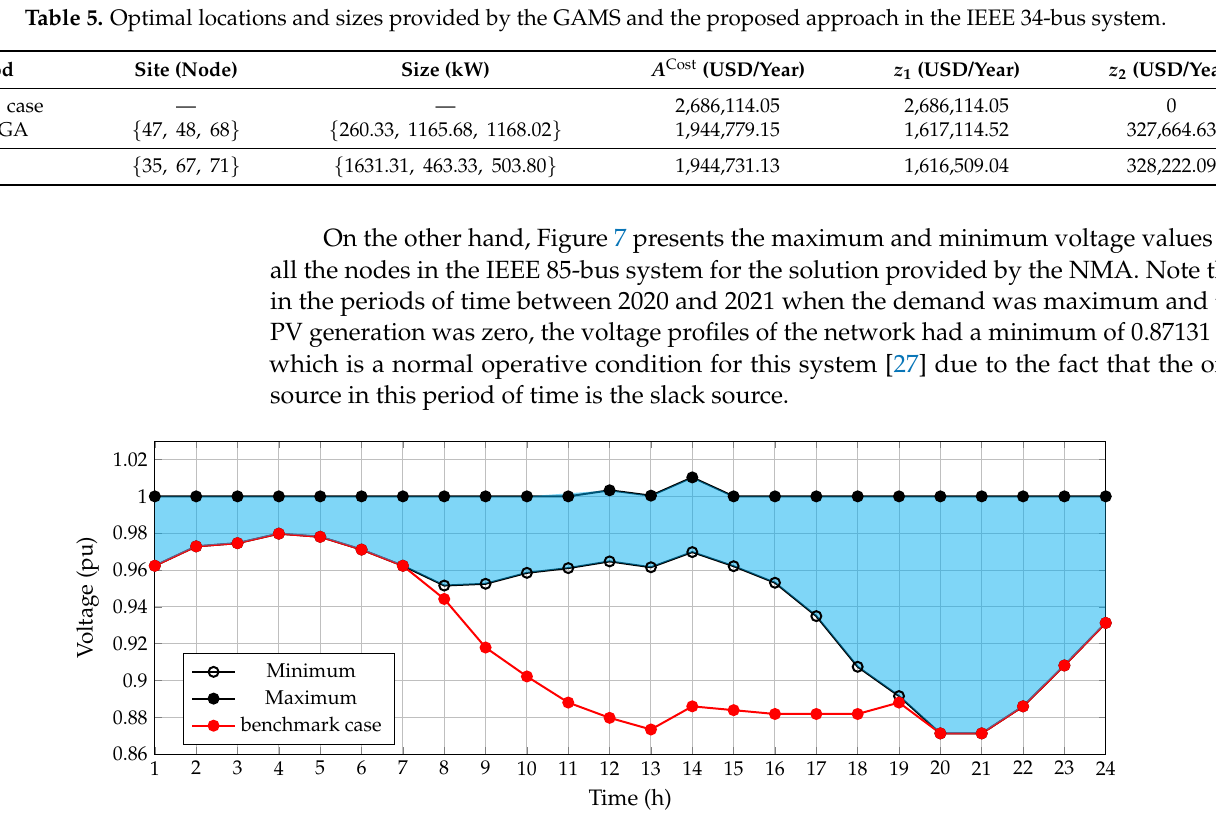
Figure 7. Minimum and maximum voltage magnitudes in the IEEE 85-node test feeder when the NMA solution is